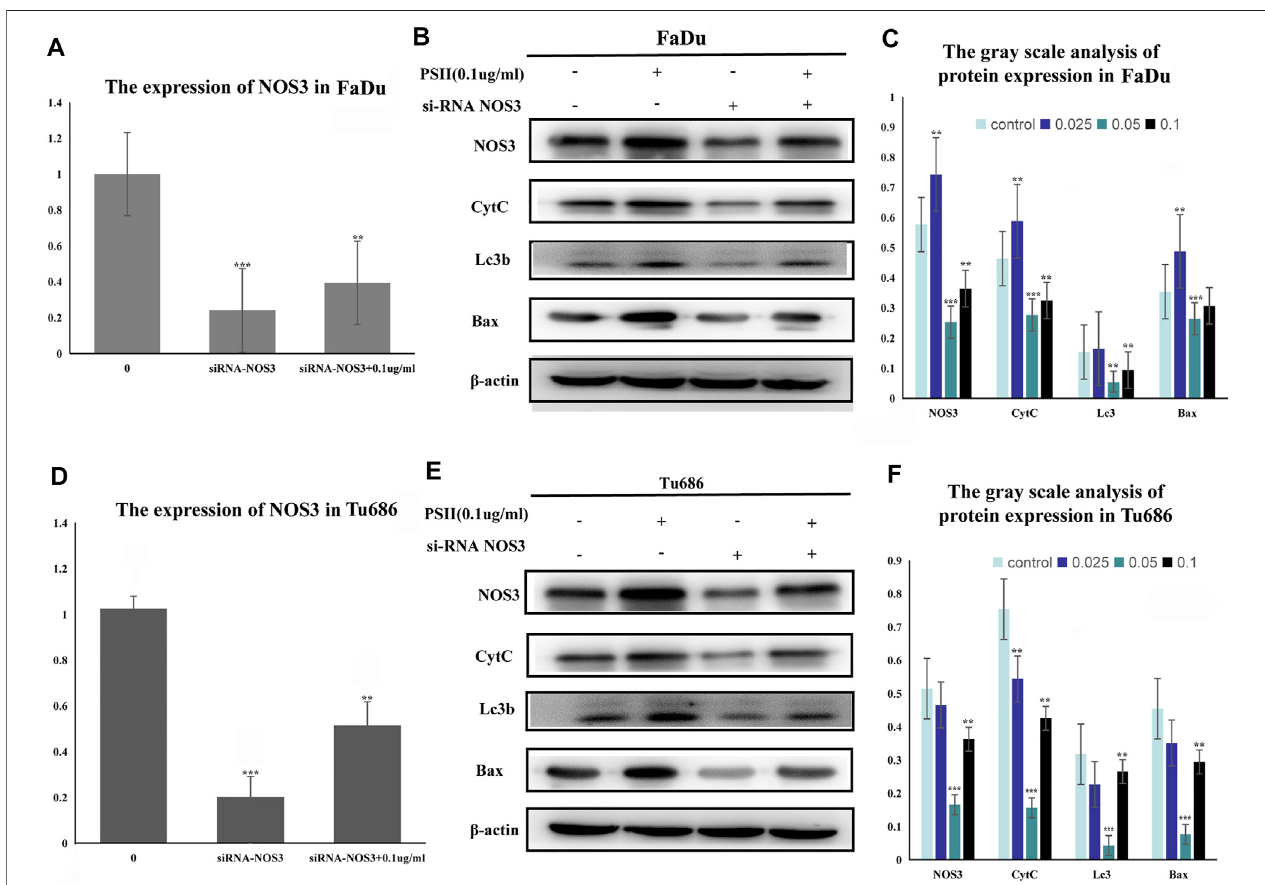
FIGURE9| InhibitiveeffectofPSIIonhumansquamouscellcarcinomacellsbytargetingNOS3. (A) ThemRNAexpressionofNOS3inFaDucellsbyRT-PCRassay after transfection. (B) The transfection of NOS3 siRNA reversed the protein expression induced by PSII (NOS3, CytC, Lc3b, and Bax) in FaDu cells. (C) The gray scale analysisofproteinexpressioninFaDucellsbyWesternblot. (D) ThemRNAexpressionofNOS3inTu686cellsbyRT-PCRassayaftertransfection. (E) Thetransfectionof NOS3 siRNA reversed the protein expression induced by PSII (NOS3, CytC, Lc3b, and Bax) in Tu686 cells. (F) The gray scale analysis of protein expression in Tu686 cells by Western blot. We used β -actin as control. All the experiments were carried out three times. Each data represent the mean ± SD of three independent experiments (* p < 0.05; ** p < 0.01; *** p < 0.001 vs the control